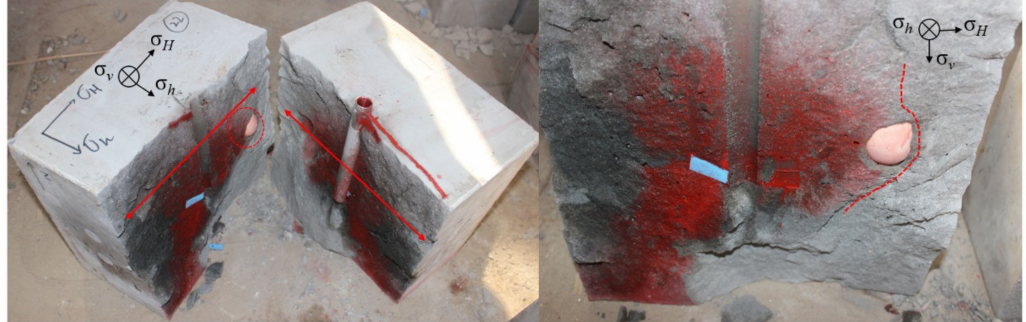
Figure 7. Hydraulic fracture geometry of sample